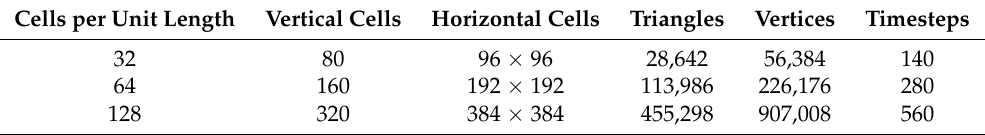
Table 2. Investigated level-set resolutions, corresponding initial domain resolutions, the number of triangles and vertices in the initial surface mesh, and the number of required timesteps until simulation time T =